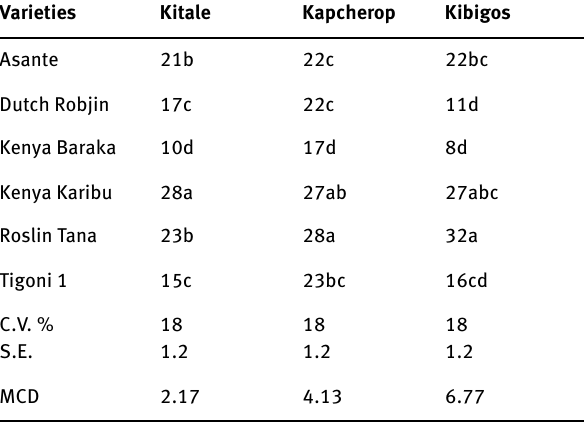
Table 3: Interactions between the site and variety on tuber yield